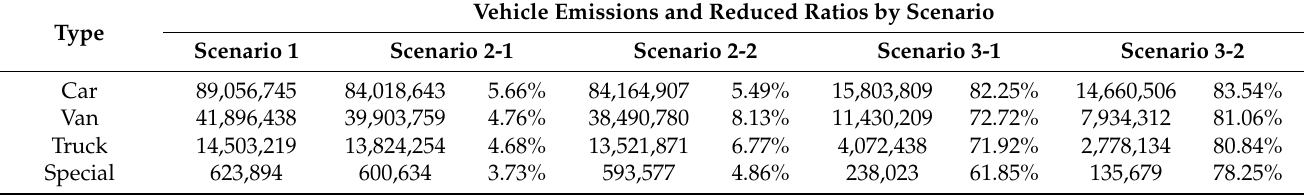
Table 4. Vehicle emissions and reduction efficiency by vehicle type.